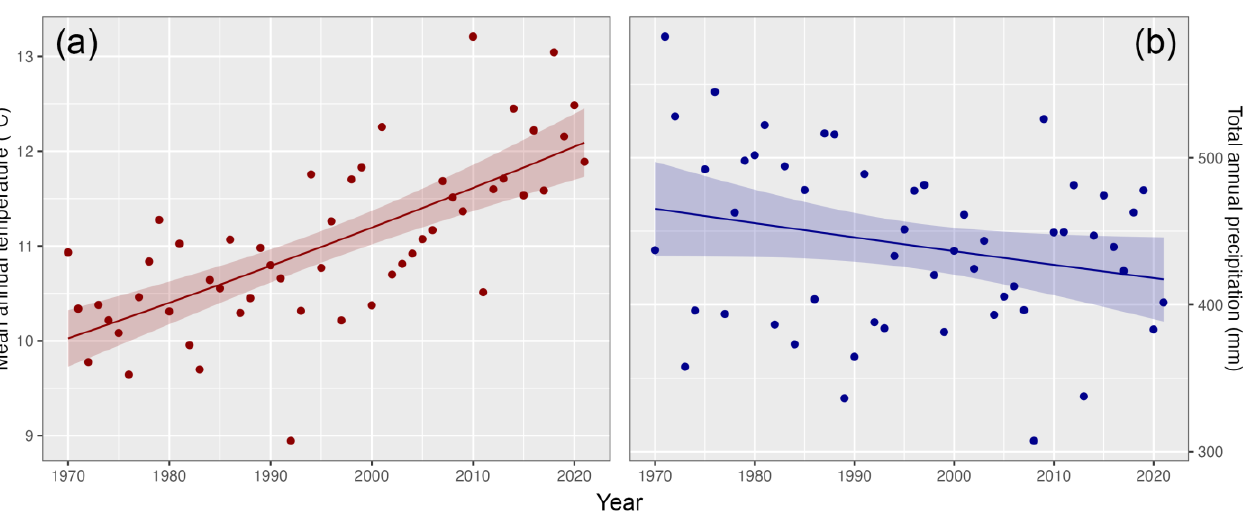
Figure 4. Changes in mean annual temperature ( a ) and annual total precipitation ( b ) for the period 1970–2021. Points: data points; solid lines: predicted values (from the generalized linear models—see Section 2.3); ribbons: 95% confidence intervals of the predicted values (from the generalized linear models).